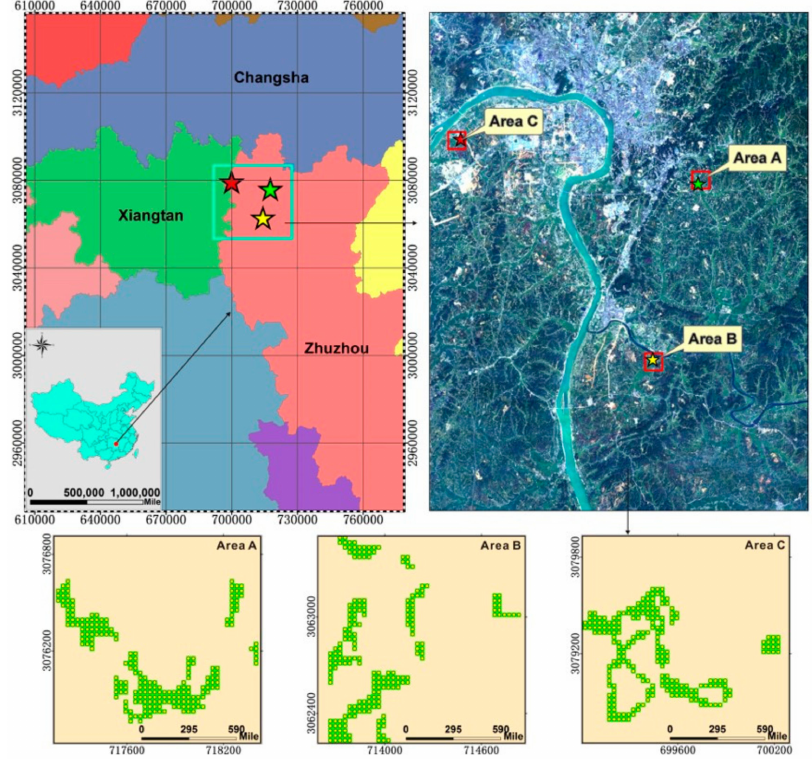
Figure 1. The geographical location of the study area in Hunan Province, China, and the spatial distribution of sample